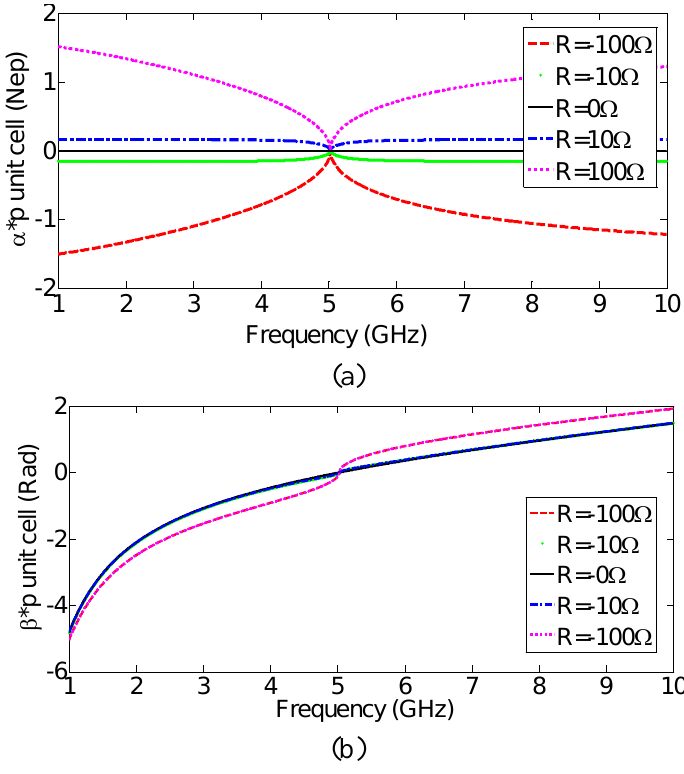
Figure 4. ( a ) Attenuation constant  and ( b ) phase constant  , of several CRLH-TLs with different series resistance values.